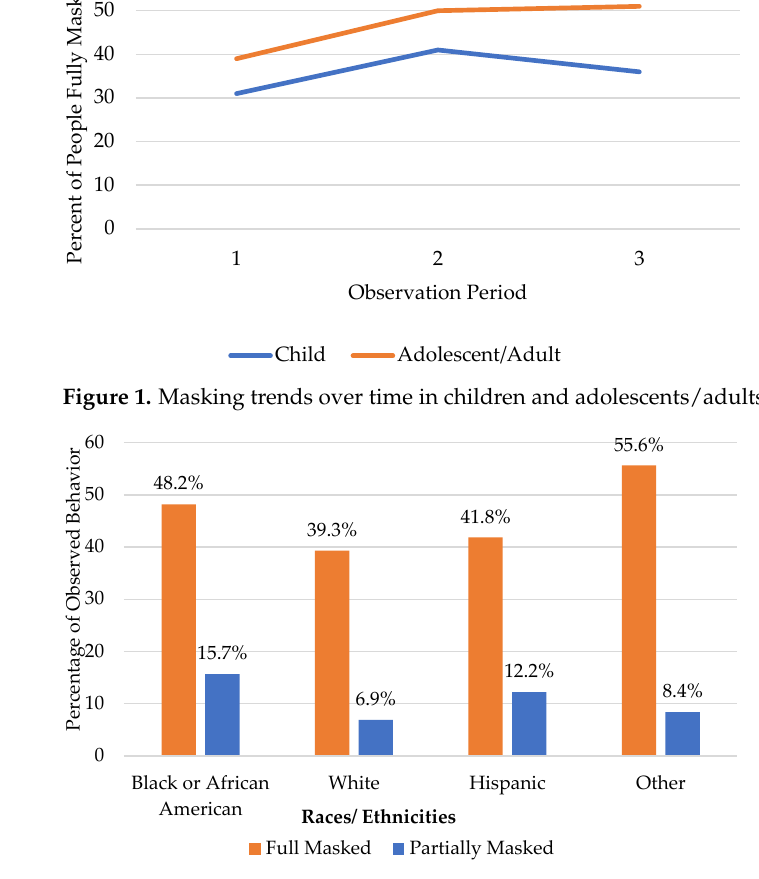
Figure 2. Overall masking behaviors by race/ethnicity. Figure 3 highlights the differences in masking behaviors seen at the various estab- lishments based on signage in a particular location. The results indicate that, as compared to establishments with no mask-related signage, individuals in establishments with